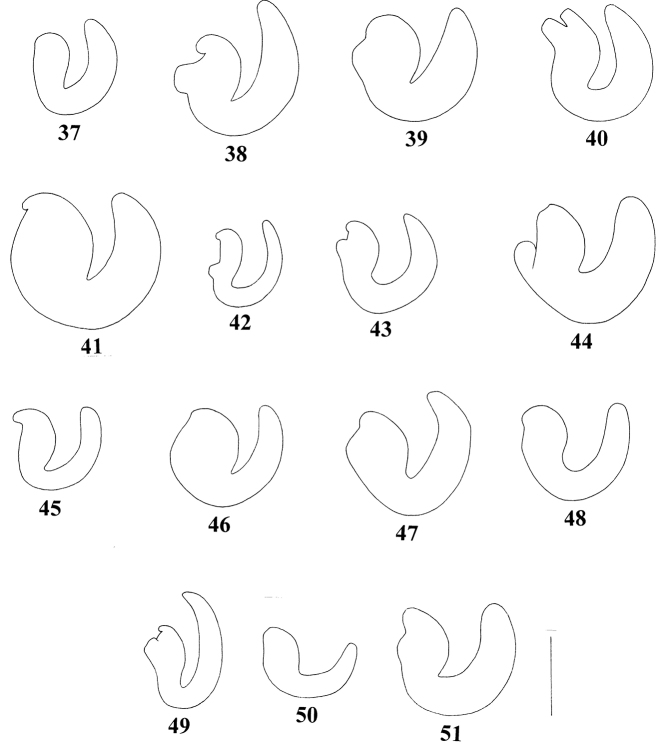
Spermatheca of Pseudocneorhinus species 37Pseudocneorhinusglaber sp. nov. 38P.hlavaci sp. nov. 39P.setosicallus sp. nov. 40P.adamsi41P.alternans42P.bifasciatus43P.hirsutus44P.longisetosus45P.minimus46P.obesus47P.sellatus48P.setosus49P.squameus50P.squamosus51P.subcallosus. Scale bar: 0.25 mm.